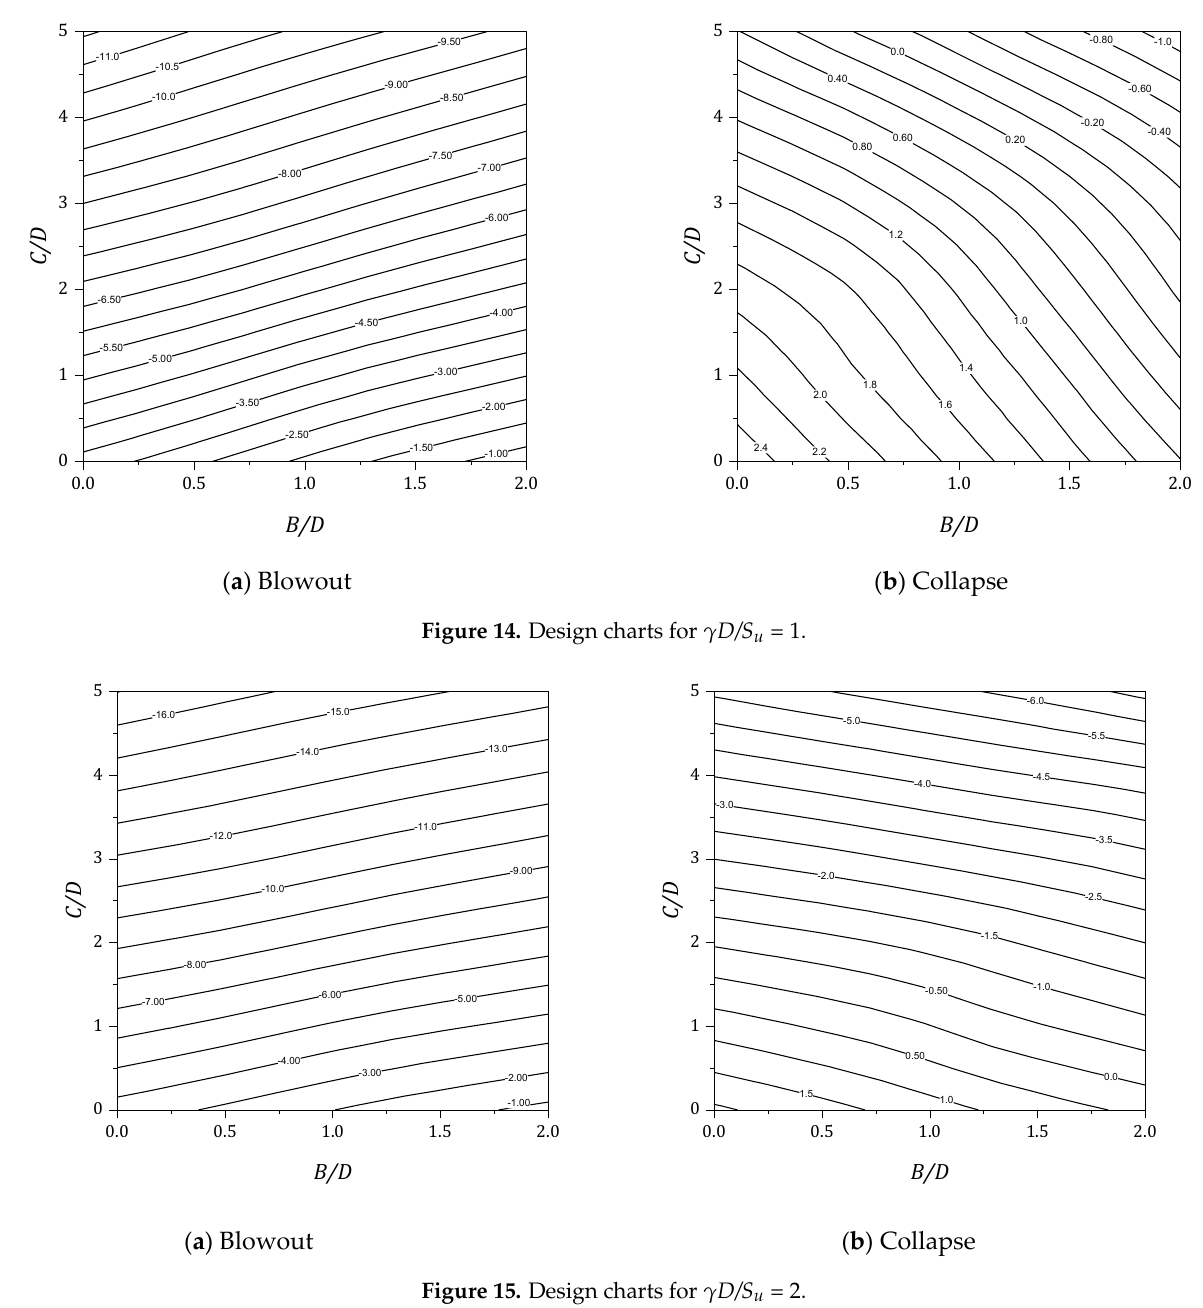
Figure 15. Design charts for γ D/S u = 2. Contour plots of the absolute velocity fields of the elliptical cavity shape transforma- tion are presented in Figures 17–19 for various width to height ratios ( B/D = 0.5, 1 and 2). These plots are both blowout and collapse modes with a shear strength ratio ( γ D/S u = 2) and two depth ratios ( C/D = 1 and 3). In general, the failure extent in the collapse mode is greater than that in the blowout mode. This observation is supported by noting the location of the initial slip surface points from the inner cavity (see Figure 19). A chimney- type of failure is presented for the shallow depth ratio C/D = 1 in both the blowout and collapse scenarios and larger lateral expansions are seen in the deeper case C/D = 3, which supports the fact that greater σ t is needed to cause soil blowout failure or to prevent soil collapse. Noting that the absolute values of the coloured velocity fields are not real for such a perfectly plasticity soil model, and therefore they are not presented